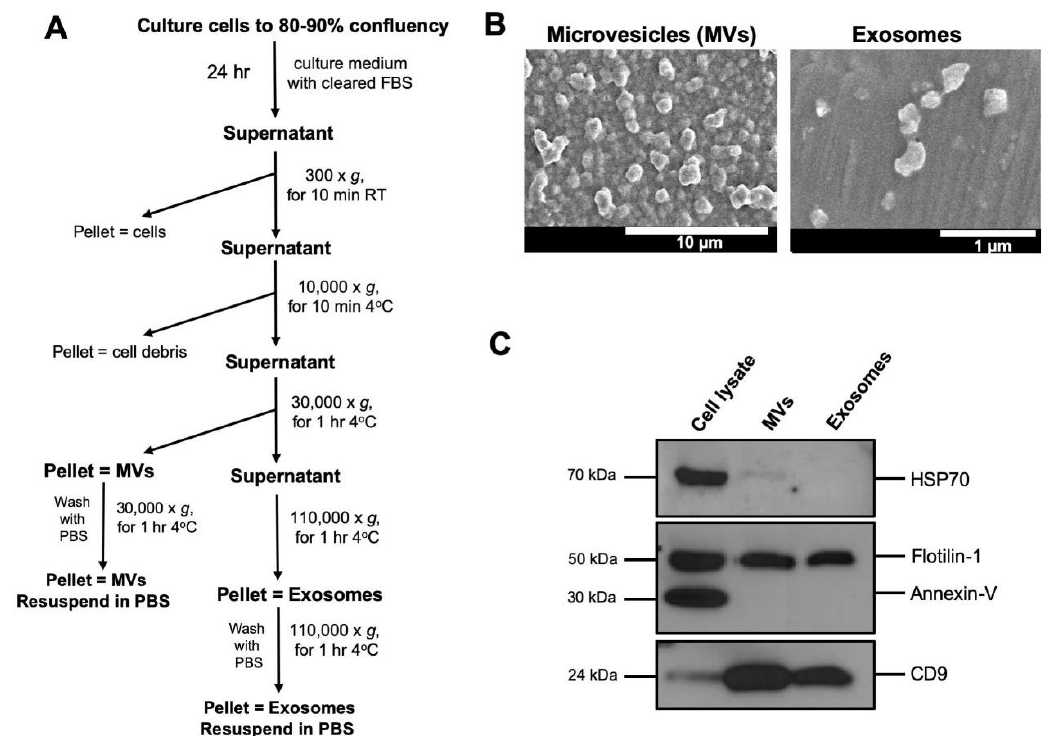
Figure 1. Isolation and characterization of extracellular vesicles (EVs) from A549 cells. ( A ) The workflow of differential ultracentrifugation for extracellular vesicles isolation is shown. ( B ) Scanning electron microscopy of microvesicles (MVs) (left panel) (scale bar = 10 µm) and exosomes (right panel). Scale bar = 1 µm. EVs were isolated from A549 cells cell culture medium by differential ultracentrifugation at 30,000× g and 110,000× g , respectively, and negatively stained for observation under the EM. ( C ) Proteins from whole cell lysates, MVs, and exosomes from cultured cells were separated on SDS-PAGE, followed by western blotting using antibodies against CD9, HSP70, Flotilin-1, and Annexin V.